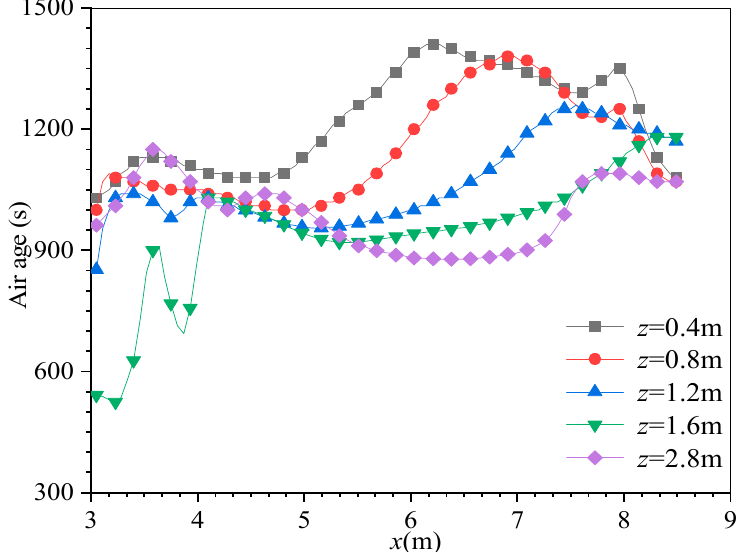
Figure 14. Comparison of air age at different heights under the same path.